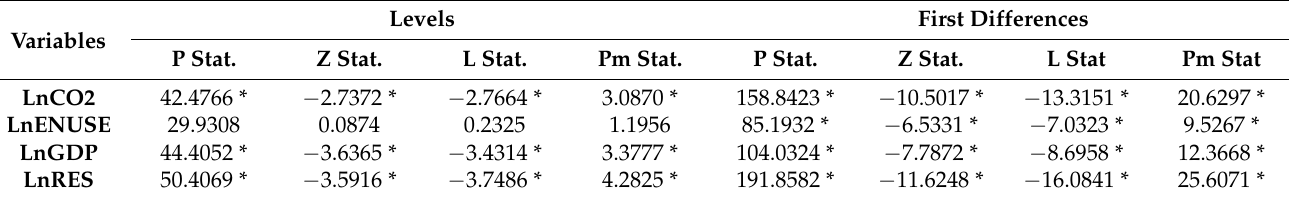
Table 4. Second-generation Fisher-type unit-root